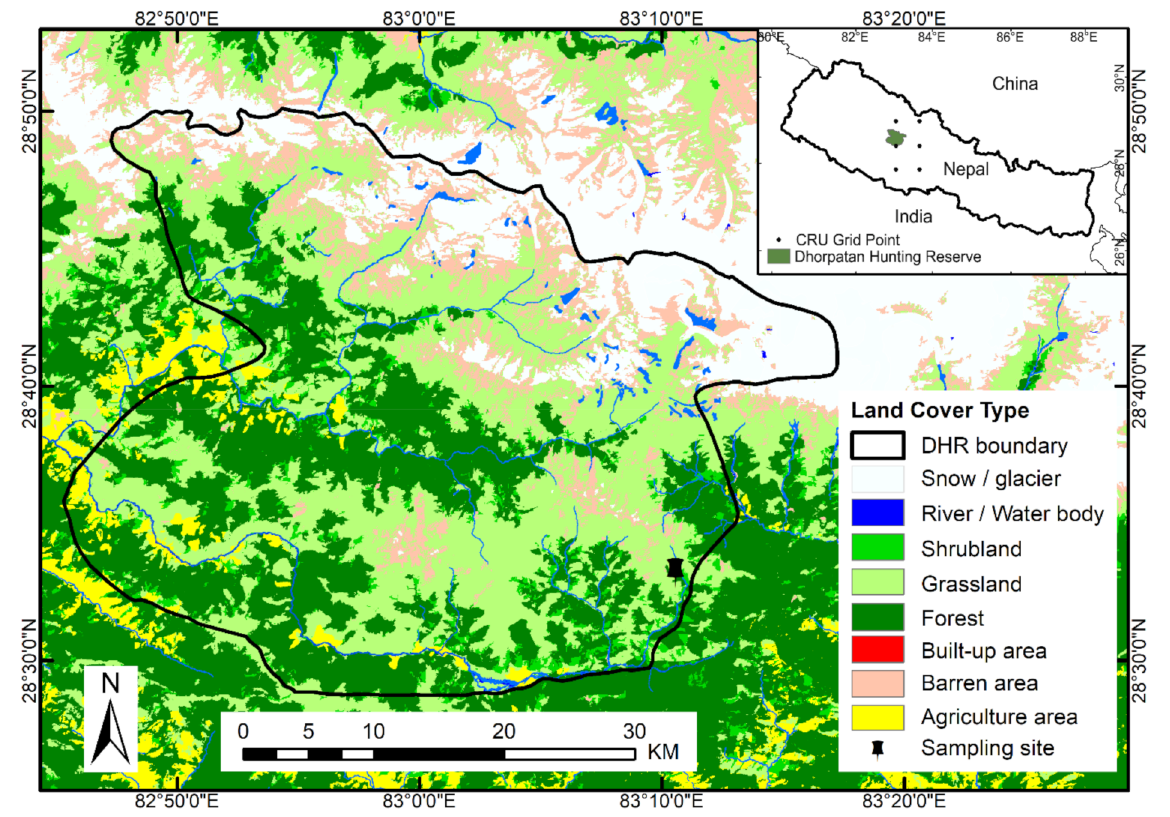
Figure 1. Land cover around the study area. The dots in the inset are the approximate position of Climatic Research Unit (CRU) grid cells. (Landcover data source: ICIMOD